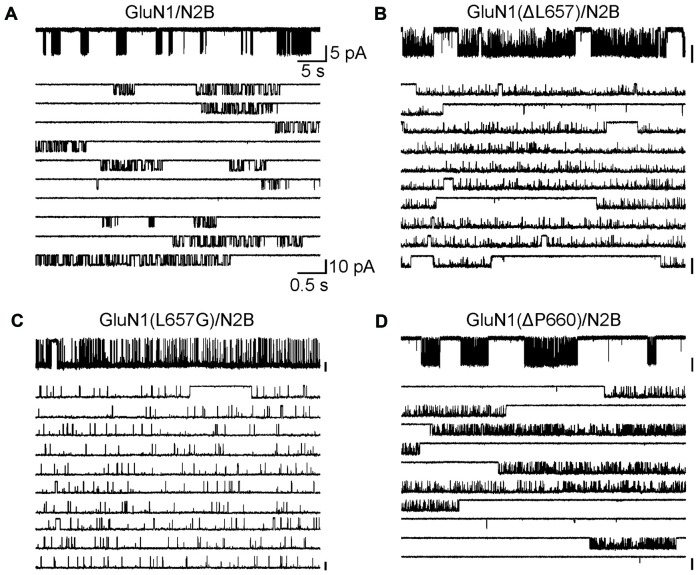
The GluN1(ΔL657) and GluN1(L657G) mutations alter single-channel properties. (A–D) Portions of steady-state cell-attached patch records, each containing only one active channel filtered at 1 kHz (for the purpose of the presentation only) from HEK293 cells expressing WT receptors (A), GluN1(ΔL657)/GluN2B (B), GluN1(L657G)/GluN2B (C), or GluN1(ΔP660)/GluN2B (D) receptors. Each record is expanded below to 10 traces (1 kHz). Unitary currents were activated in these patches by 1 mM glutamate and 0.1 mM glycine.